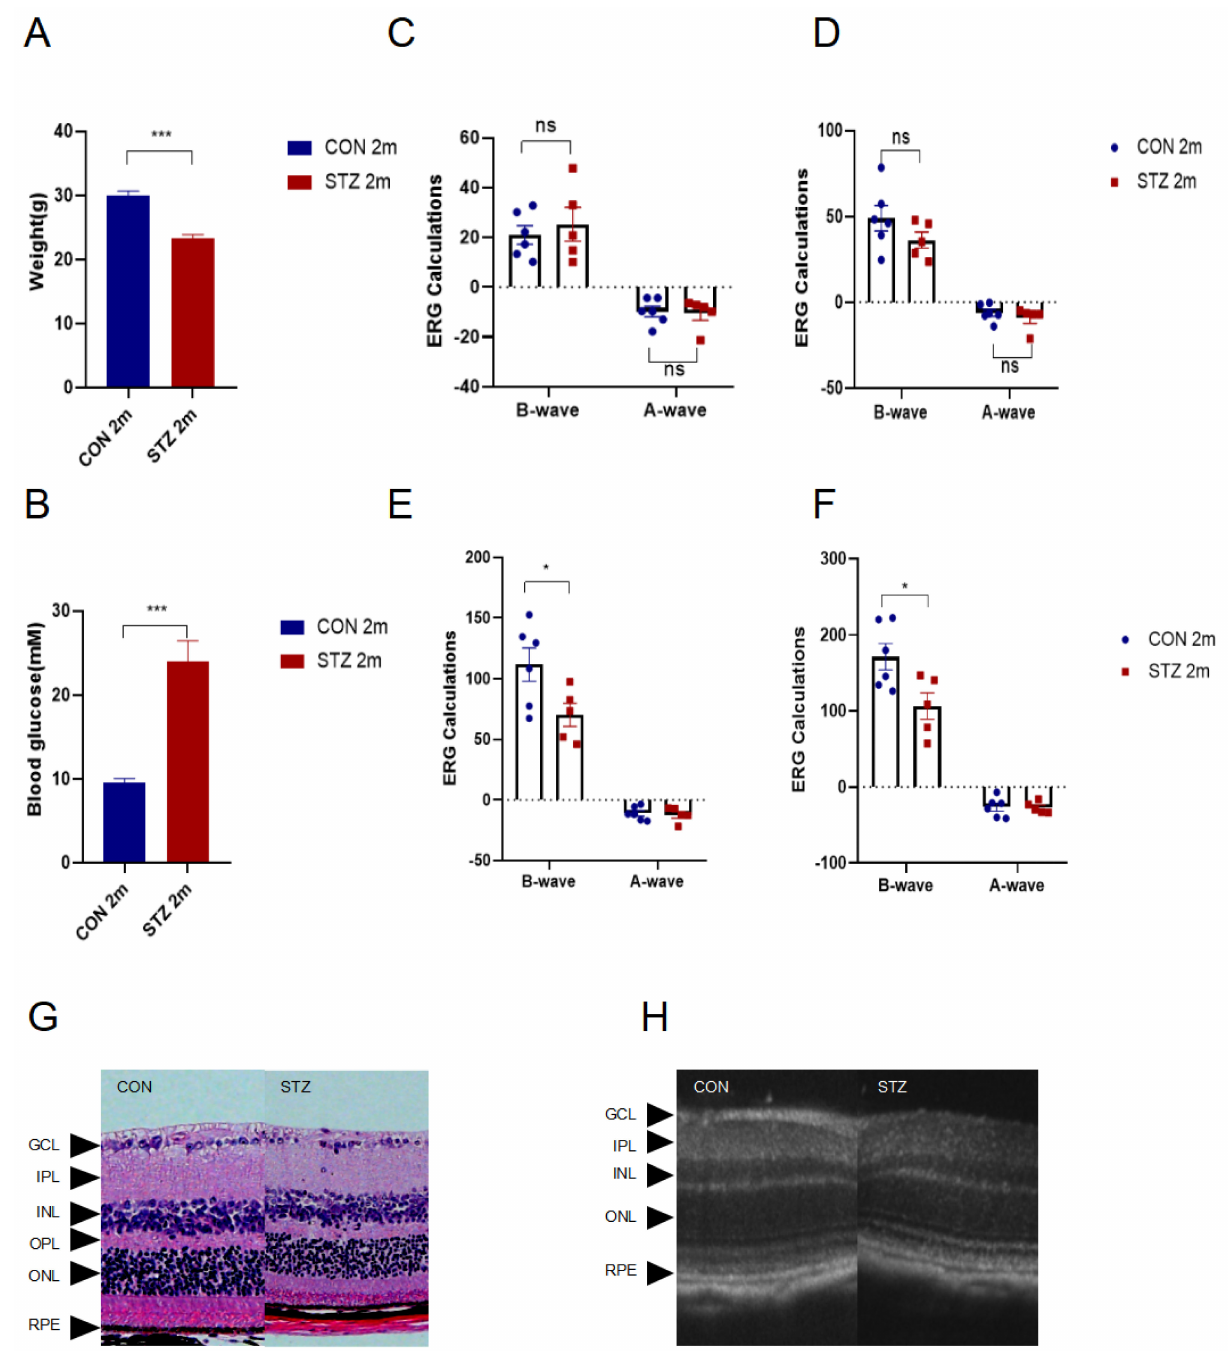
Figure 1. Establishment of DR mice models by intraperitoneal injection with STZ ( n = 3). ( A , B ). Two months later, weight and blood glucose of mice were measured. ( C – F ). ERG recordings of flash 1, 2, 3, 4 in DR mice models. Bar graphs showed mean ± SD. p -values: Student’s t -test. (*** p < 0.001, p < 0.01, * p < 0.05, ns p > 0.05). ( G ). H & E staining of eyeball histology. ( H ). Eyeball histology showed by OCT in vivo. Asterisks point to different layers of retina. STZ: Streptozotocin; ns: not significant; GCL: Ganglion cell layer; IPL: Inner plexiform layer; INL: Inner nuclear layer; OPL: Outer plexiform layer; ONL: Outer nuclear layer; RPE: Retina pigment